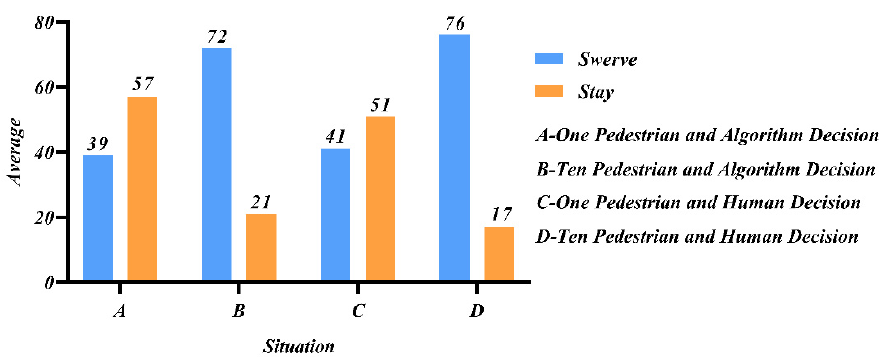
Figure 7. Participants’ preferences in different